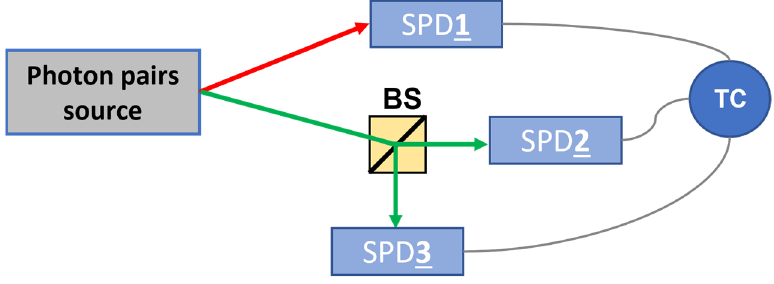
Figure 4. HBT interferometer scheme for characterizing the heralded single photon source purity. BS: beam splitter; SPD: single photon detector; TC: time controller.